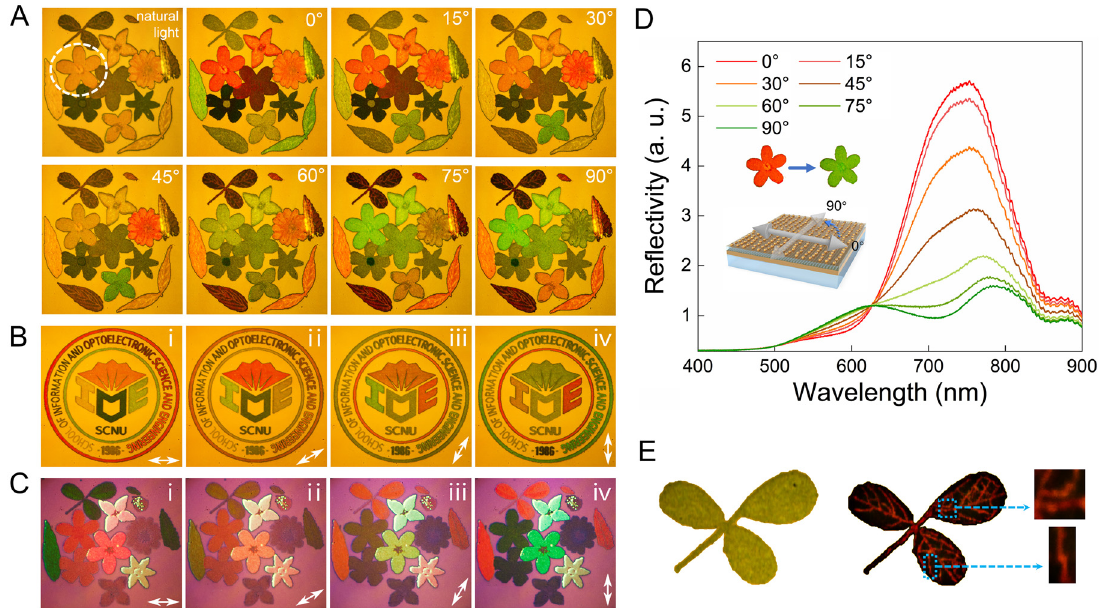
Figure 5: Polarization sensitive color display realized by using nanogratings. (A) Microscope images of flowers and leaves observed by irradiating the pattern with un-polarized white light and white light with different polarization angles. (B) Microscope images obtained by irradiating the pattern with an unpolarized white light and observed after a polarization analyzer with different polarization angles of 0 ° , 30 ° , 60 ° , and 90 ° (i – iv). (C) Microscope images obtained under the same conditionsin(D)forasamplewitha70nmthickpolymer fi lm.(D)Re fl ectionspectrameasuredfor fl owerNo.7(enclosedbydashedcirclein(A)) which is irradiated with white light of different polarization angles with respect to the nanograting. 0 ° and 90 ° correspond to the white light whosepolarizationsparallelandperpendiculartothevectorofthenanograting,asshownintheinset.(E)LeafNo.1observedunderwhitelight illumination with polarization angles of 0 ° (left) and 90 ° (right). The enlarged parts of the veins indicate a spatial resolution close to a pixel ( ∼ 0.70 μ